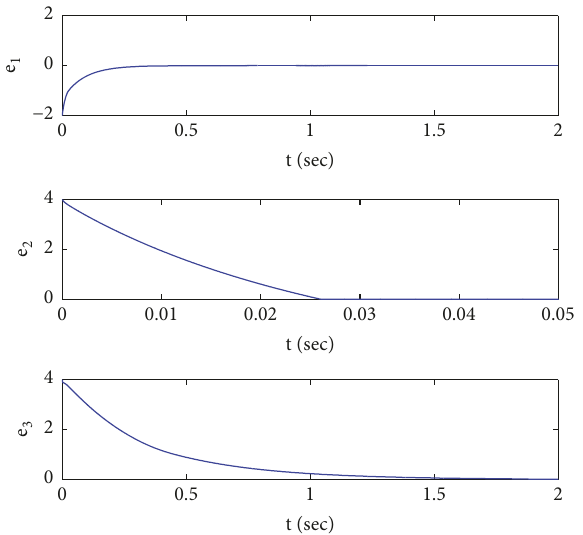
Figure 4: The time response of synchronization errors 𝑒 1 , 𝑒 2 ,𝑒 3 between system (46) and response system